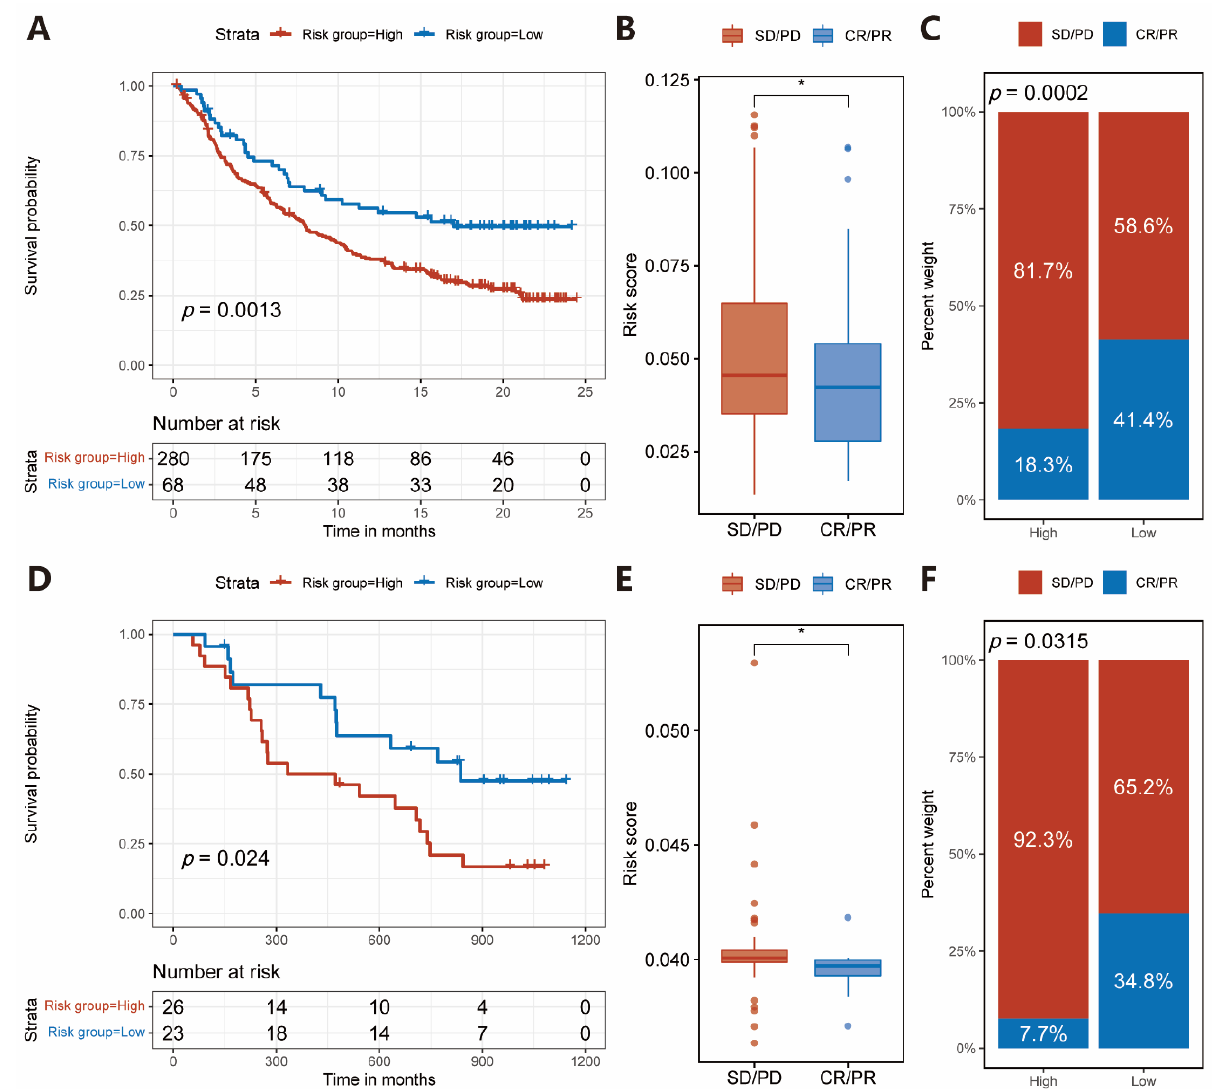
Figure 5. Response to immunotherapy in patients of urothelial cancer and melanoma with different risk groups divided by risk score. ( A ) K–M curve for patients of urothelial cancer in the high- and low-risk groups in the IMvigor210 cohort. Log-rank test, p = 0.0013. ( B ) Risk score in groups with a